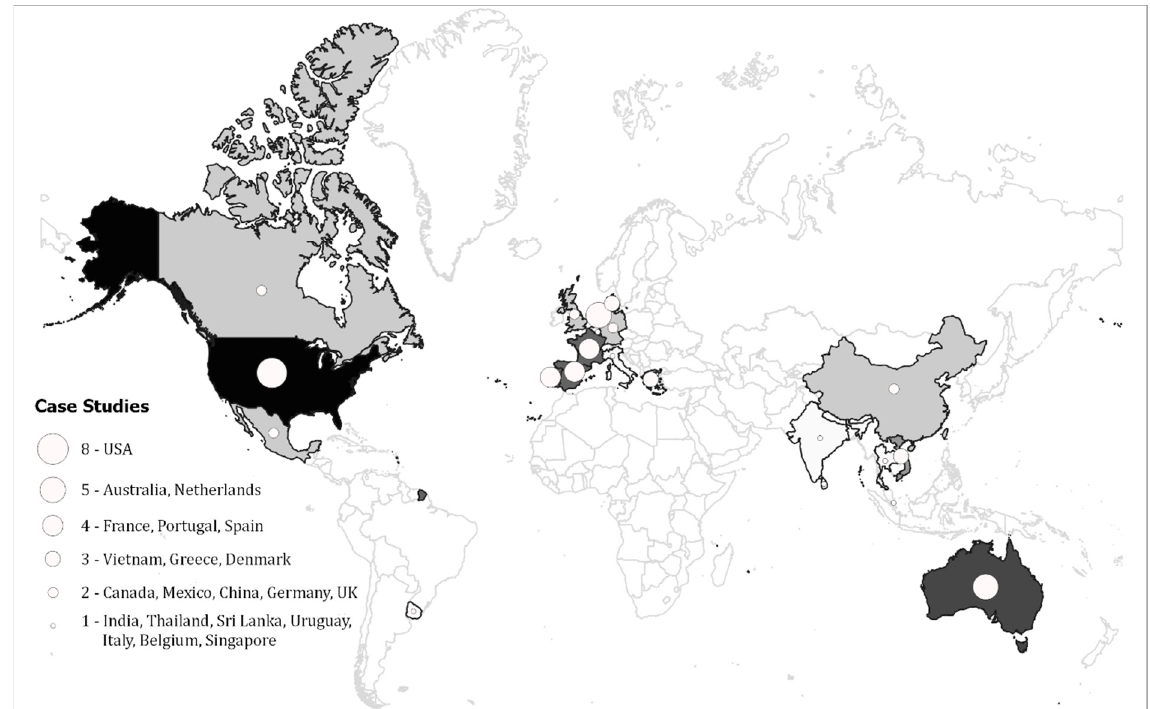
Figure 2. Geographical location of case studies.